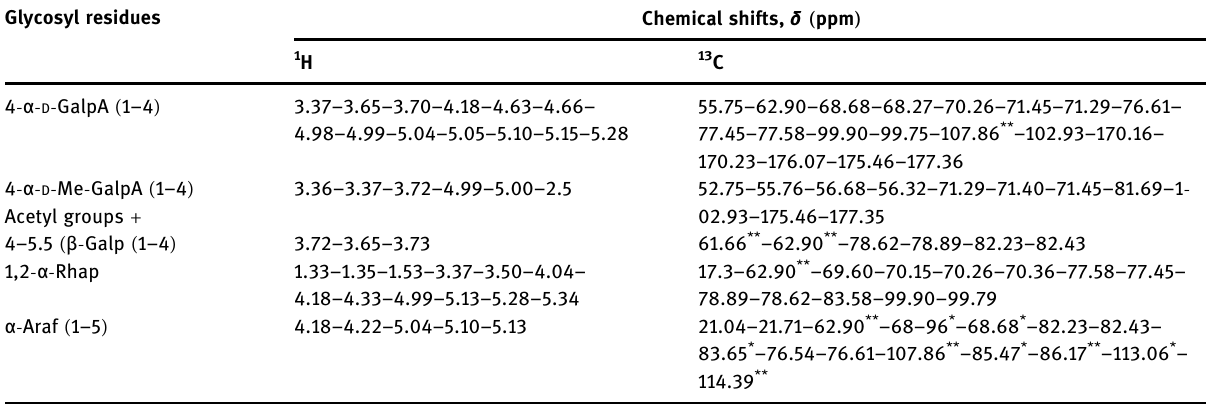
Table 2: Chemical shifts of glycosyl residues of PuP and PeP obtained by 1 H and 13 C NMR spectroscopy Glycosyl residues Chemical shifts, δ ( ppm